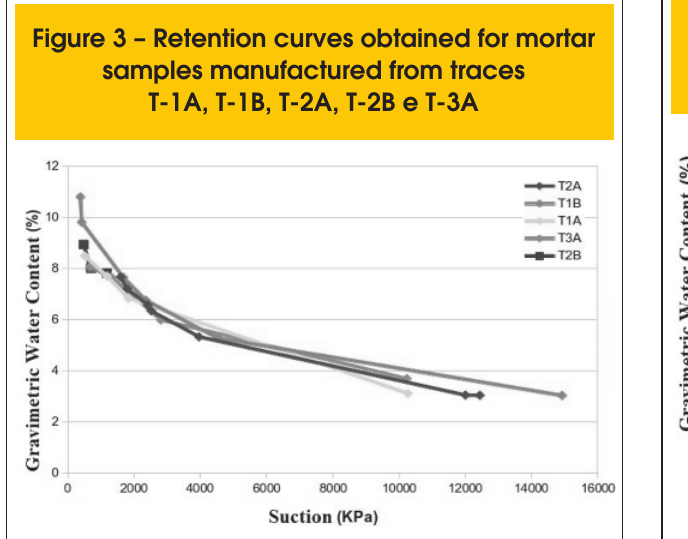
Figure 3 – Retention curves obtained for mortar samples manufactured from traces